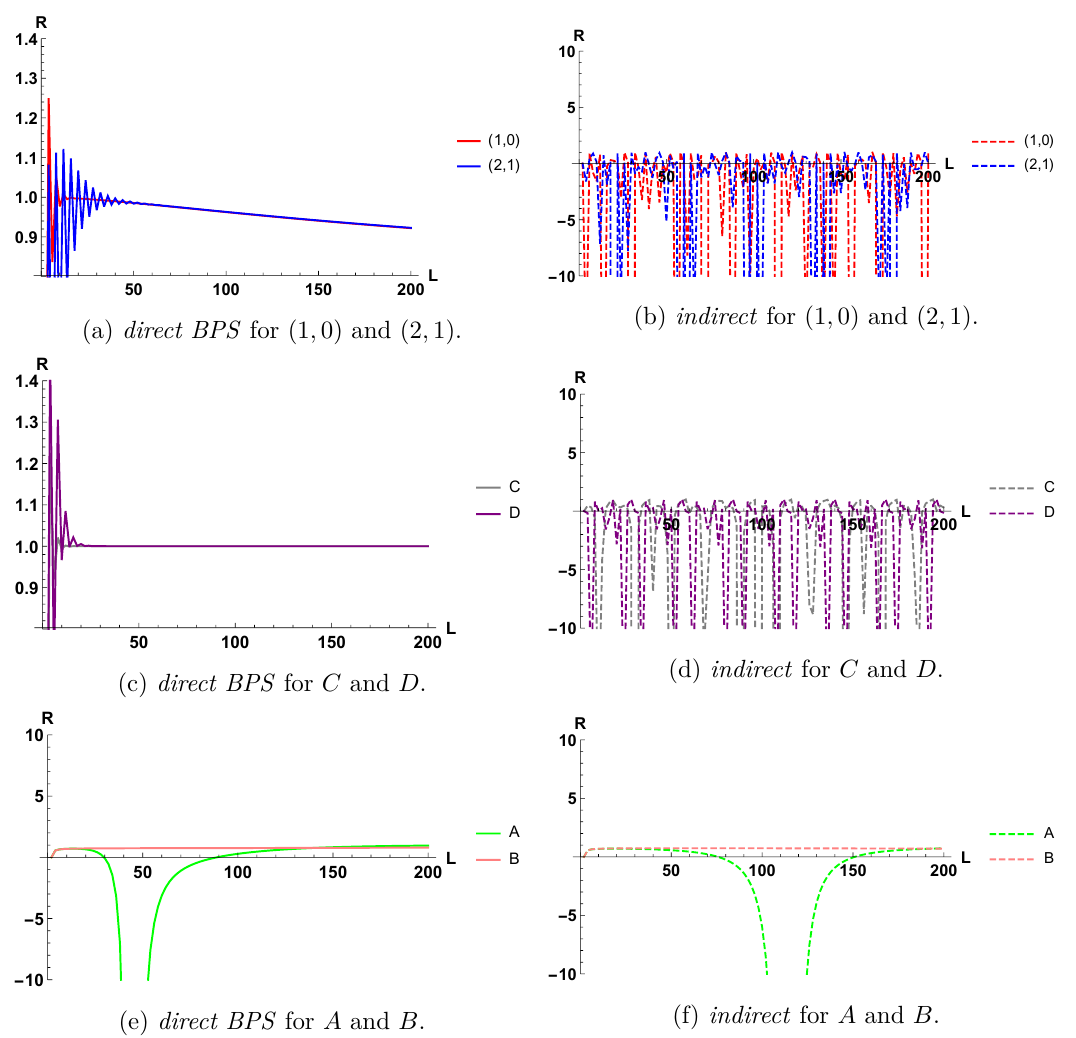
Figure 3. R ( M ) ( L, δ = 1 / 2) as a function of L for the six geometries we are considering. We see 2 that the indirect method produces highly oscillatory results while the direct BPS method produces smooth